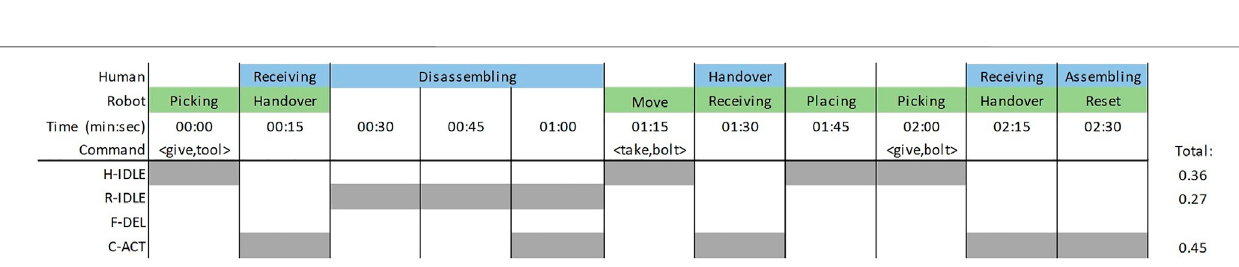
FIGURE4| Taskassignmentchartforhand-overtasksbygraphicalcommand-basedcoordination.Thechartdepictstheactionsofthehuman(blue)andtherobot (green) in the shared collaborative scenario. The fl uency metrics indicate a relatively low human and robot idle time (H-IDL and R-IDL) and high concurrent activity (C-ACT). Functional delay (F-DEL) is avoided